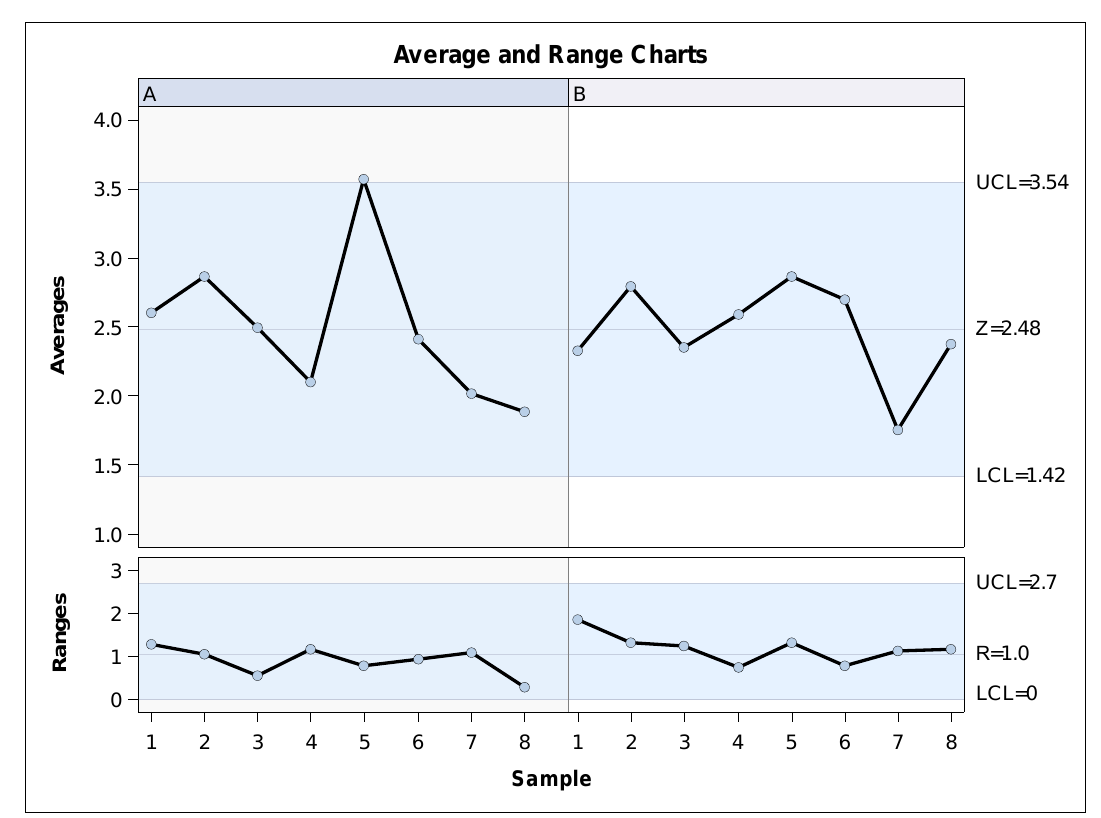
Figure 8. Charts of the average of the three measurements of the lineal measurement (mm) of the palatine suture expansion after RME procedures through McNamara appliance. Left column ( A ) is referred to Operator 1 and right column ( B ) is referred to Operator 2.